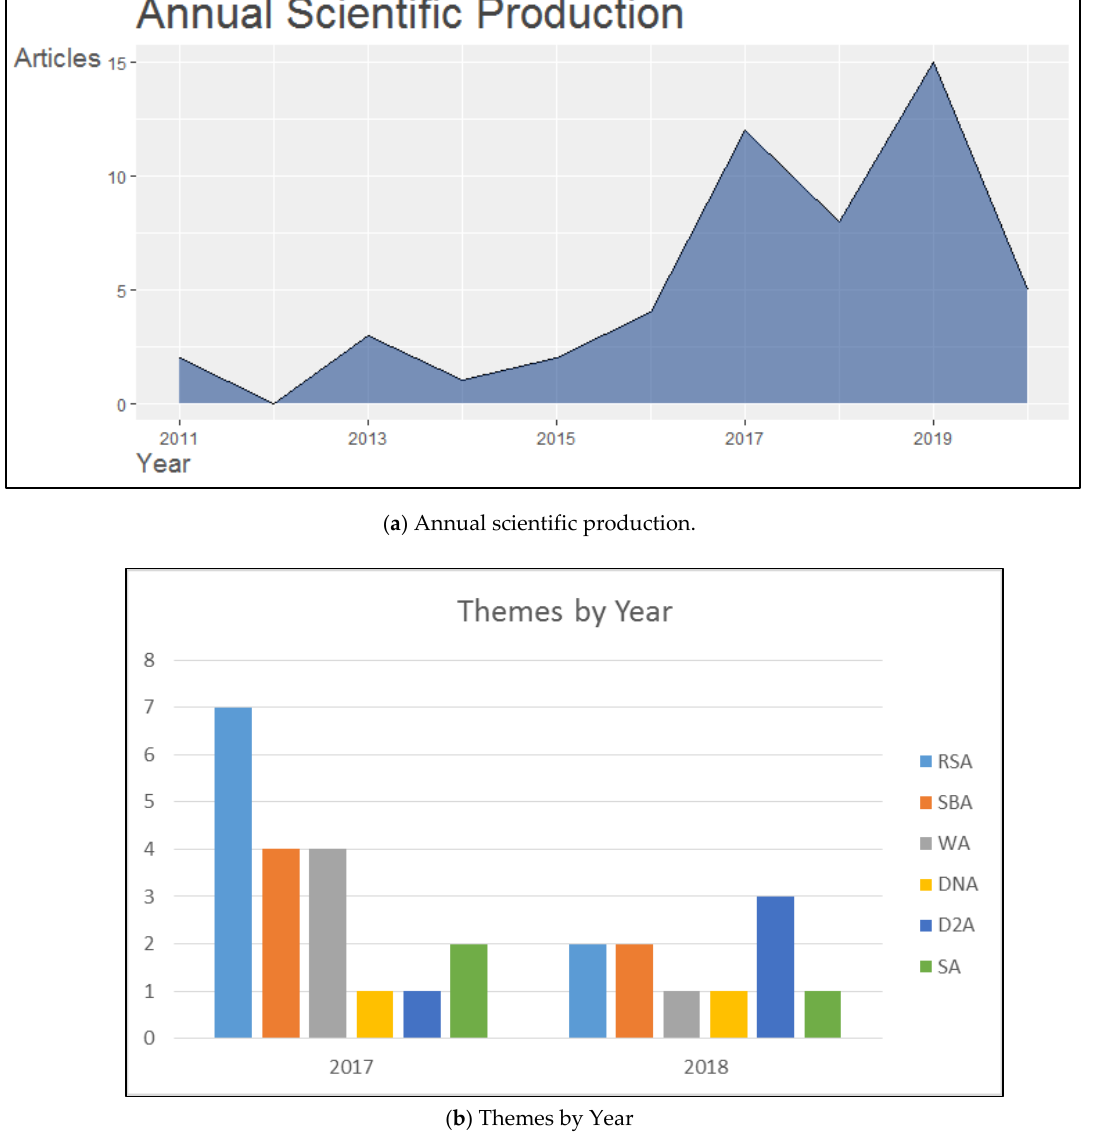
Figure 3. ( a ) Annual scientific production. ( b ) Themes by year.